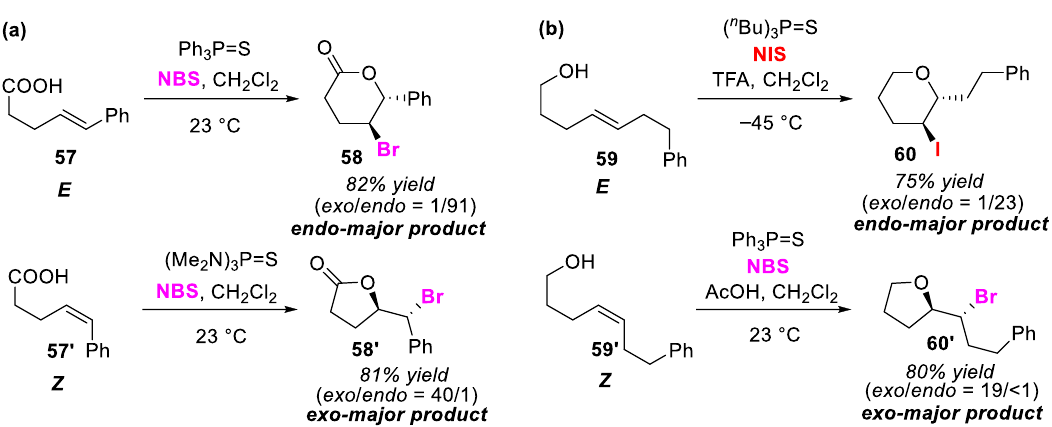
Figure 29. Endo/exo selective ( a ) bromo-lactonization reactions of a E -olefinic and Z -olefinic acids ( 57 and 5 7′ ) and ( b ) halo-cyclo-etherification reactions of a E -alkenols and Z -alkenols ( 59 and 5 9′ ).